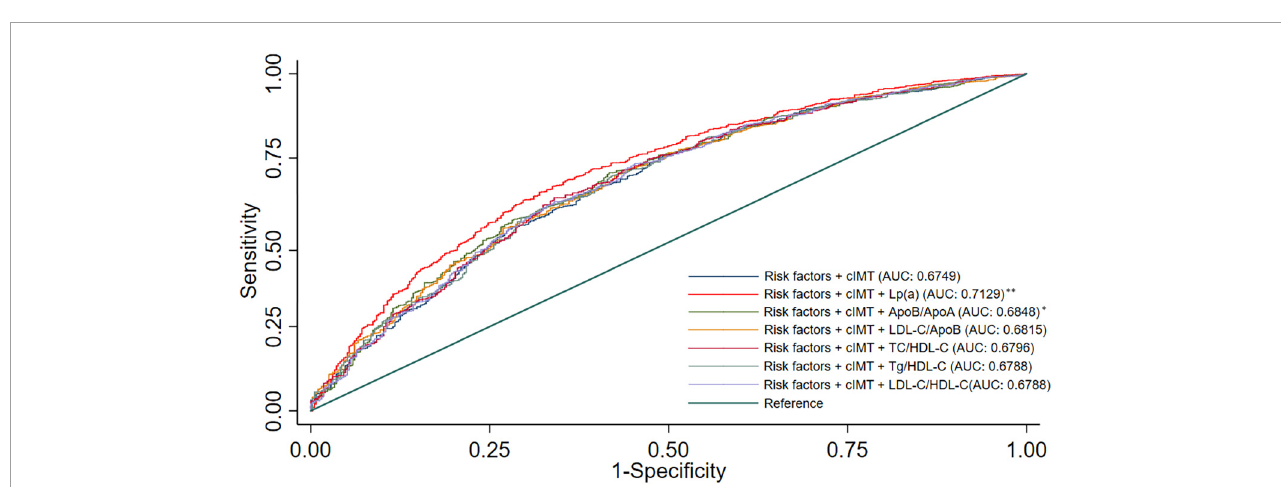
FIGURE2 Receiver operating characteristic curves for models with different lipid parameters. Illustration: Basic prediction model adjusted for age, sex, hypertension, smoking, alcohol consumption, DM, and mean-cIMT; ∗ P < 0.05 compared with basic prediction model; ∗∗ P < 0.001 compared with basic prediction model.